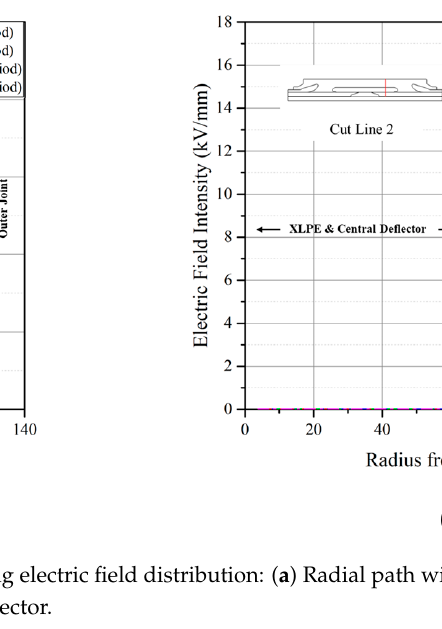
Figure 6. Electrical simulation results: ( a ) Time-varying electric field distribution and equipotential line; ( b ) Electric field profiles during the entire load cycles.